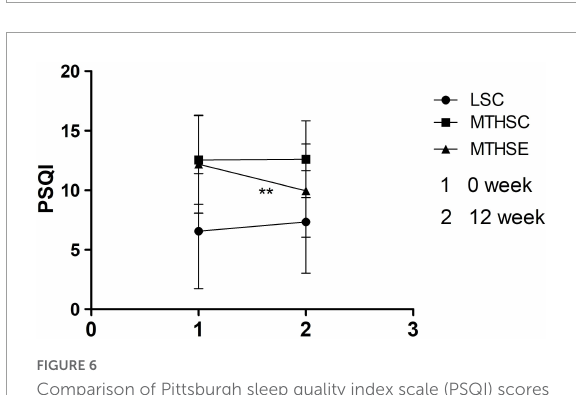
FIGURE6 Comparison of Pittsburgh sleep quality index scale (PSQI) scores pre-exercise and post-exercise. 1, Week 0 is the score of PSQI;